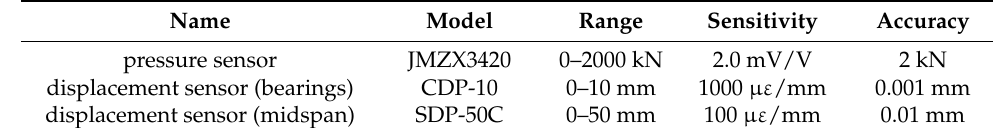
Table 2. Parameters of sensors.